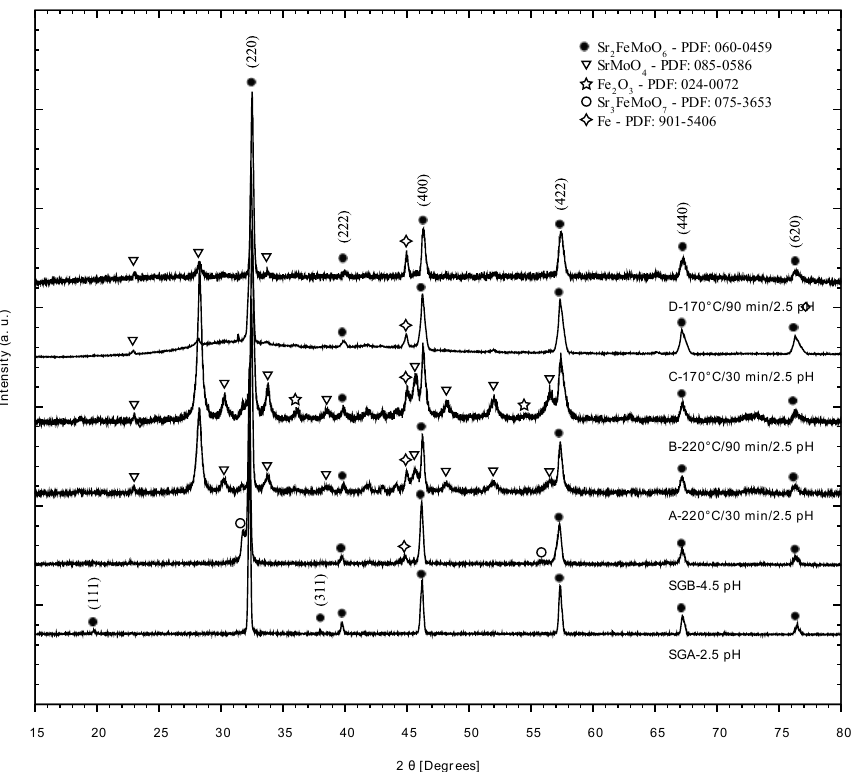
Figure 3. XRD patterns after the reduction process. Bragg reflections attributed to metallic precursor are highlighted (Sr 2 FeMoO 6 (PDF: 060-0459), SrMoO 4 (PDF: 085-0586), Fe 2 O 3 (PDF: 024-0072), Sr 3 FeMoO 7 (PDF: 075-3653), and Fe (PDF: 901-5406)).